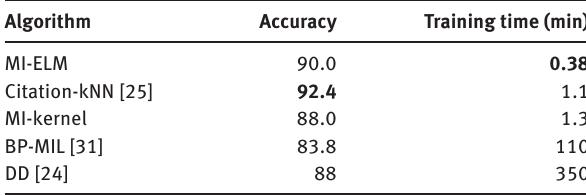
Table 3: Accuracy and Training Time on MUSK1. Algorithm